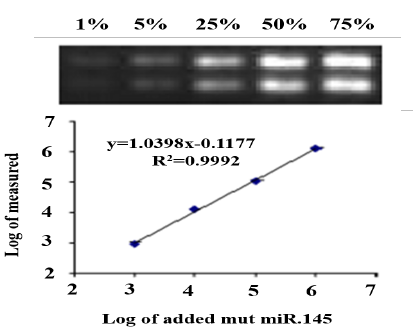
Fig. 1. Normalization of miR-145 relative to standard for 1% detection: The MCAS PCR products of the co-amplified serially diluted competitor and the fixed amount of target DNA separated on the 2% agarose gel. lane1: containing 1%; lane 2: 5%; lane 3: 25%; lane 4: 50% and lane 5: 75%.